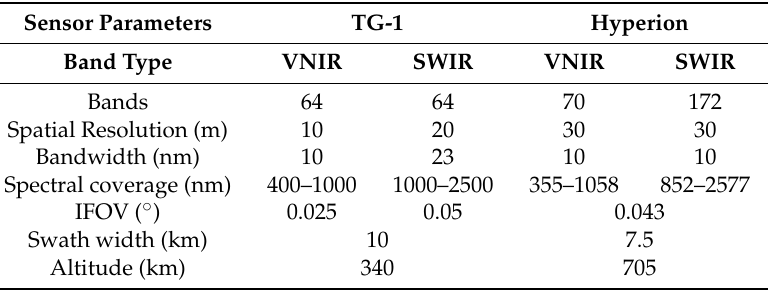
Table 1. Characteristics of TG-1 and Hyperion data used in this study. Sensor Parameters TG-1 Hyperion Band Type VNIR SWIR VNIR SWIR Bands